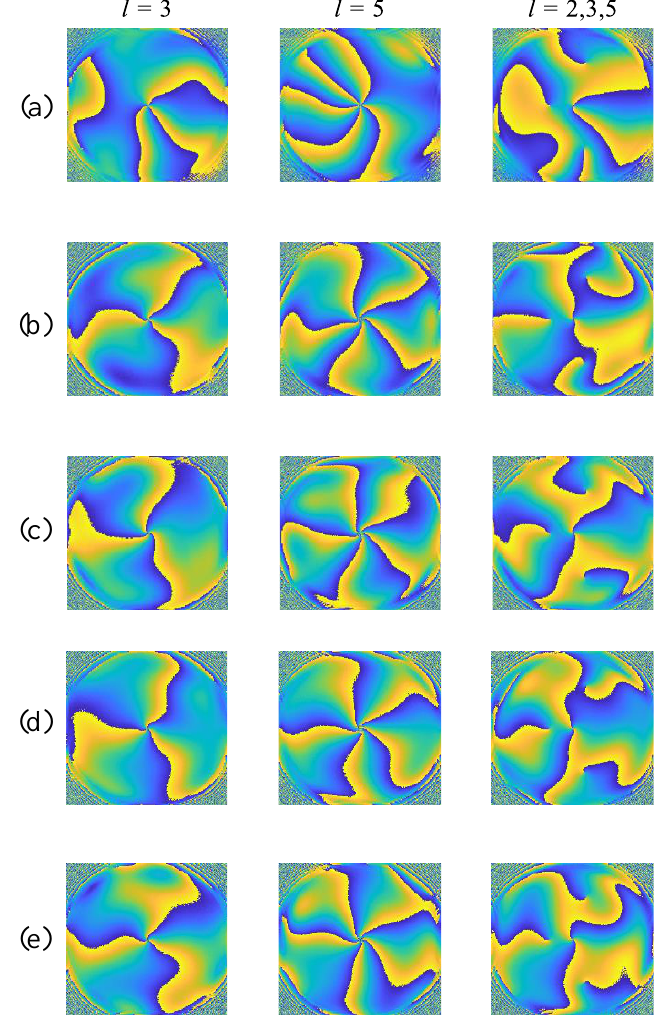
Figure 6. Comparison of results of phase recovery performed with different topological loadings: ( a ) before phase recovery; ( b ) MRWF algorithm; ( c ) WF algorithm; ( d ) TWF algorithm; ( e ) RWF algorithm.